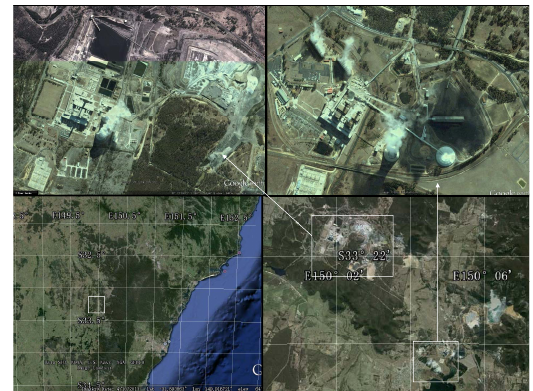
Fig. 4. An aerial view of two coal power plants at the location of the origin of the pollution track (33.38 ◦ S, 150.05 ◦ E) that is shown in Fig. 3. The power plants are 7km apart from each